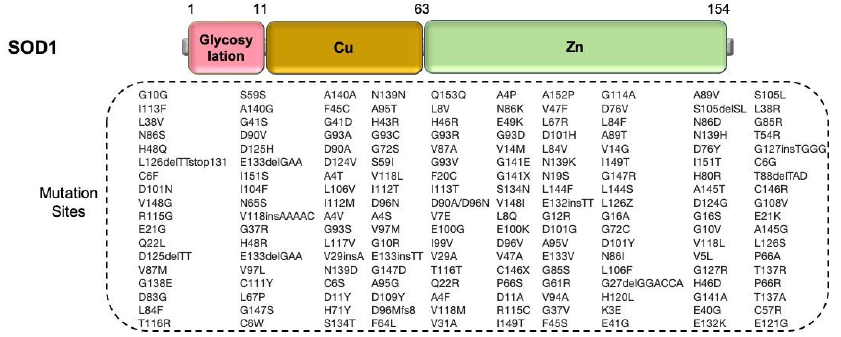
Figure 4. A scheme for exhibiting variant sites in SOD1 protein. (Top) the SOD1 protein structure; (Bottom) 180 SOD1 variants shown in ALS cases. Data were taken from the ALS online database (ALSoD) [79]. The variations are only identified on the amino acid sequence of the protein, and not all are proven to be pathogenic for ALS.